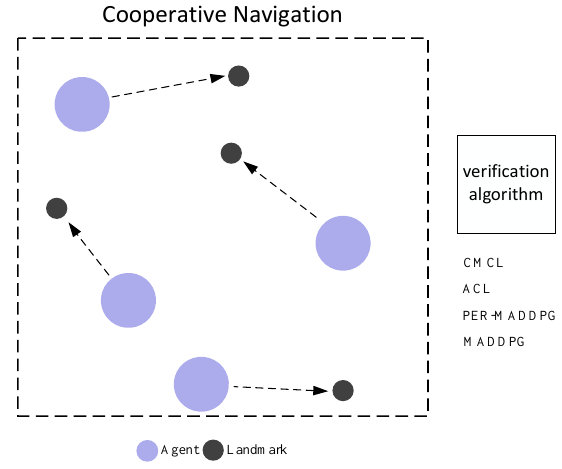
Figure 7. Cooperative navigation experimental environment.